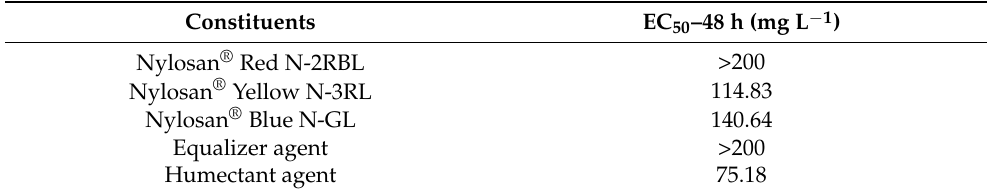
Table 3. Ecotoxicity towards Daphnia magna of Nylosan ® Yellow N-3RL, Nylosan ® Red N-2RBL, Nylosan ® Blue N-GL, Sarabid PAW and SERA WET C-NR.